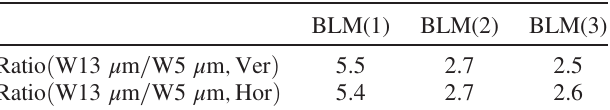
TABLE I. Ratio of the radiation-dose measured at FERMI by BLM(1), BLM(2) and BLM(3) when scanning with 5 μ m and 13 μ m tungsten wires — at a motor speed of 0 . 2 mm = s — the horizontal (Hor) and the vertical (Ver) profiles of a 300 pC electron beam (energy 1.5 GeV, 10 repetition rate). The values of the radiation-dose measured by the three BLMs at every scan were obtained by integrating the beam profiles plotted in Fig. 15. The relative distances from the WSC of the three beam-loss monitors BLM(1), BLM(2) and BLM(3) are: 2.48, 5.52 and 8.40 m,